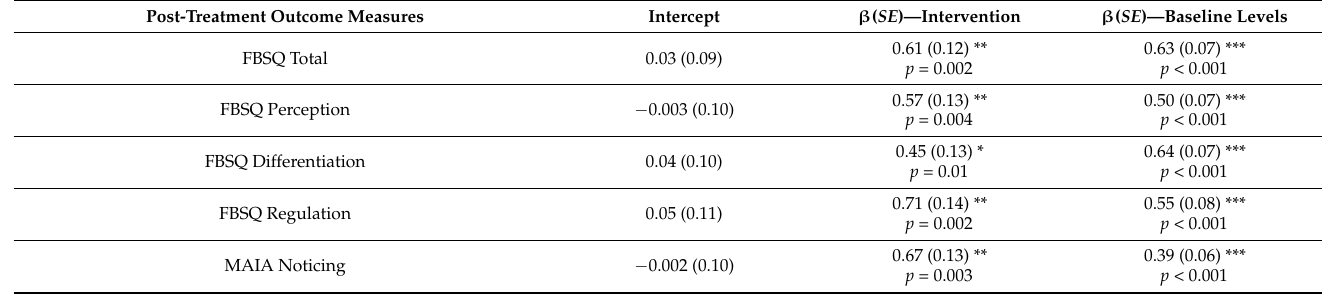
Table 3. Intervention effect on psychological parameters assessed by random-intercept multilevel